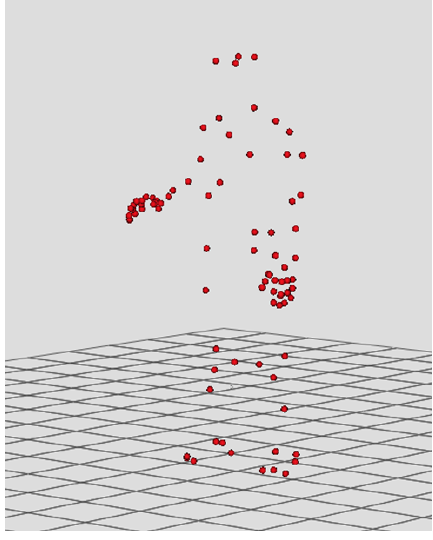
Figure 1. Marker-set